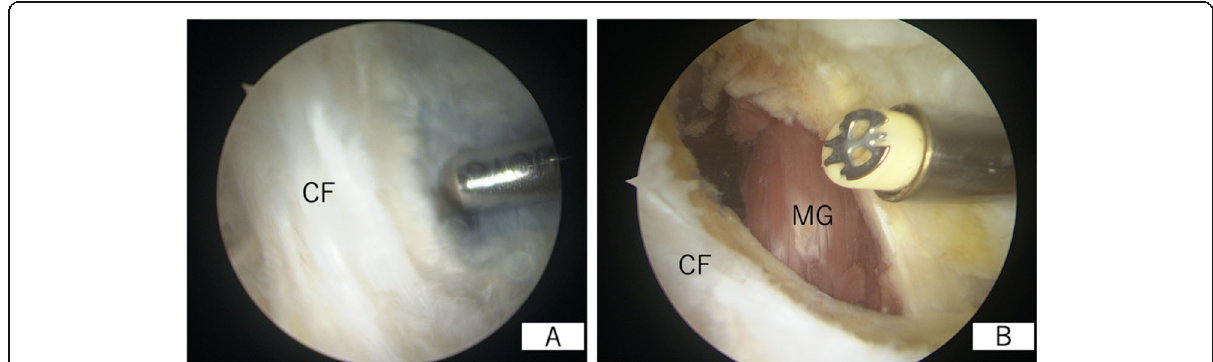
Fig. 4 Arthroscopic findings of the posteromedial compartment of the right knee via the anterolateral portal. a Indigo carmine is leaking out from the communication channel. b The arthroscopic enlargement is completed. CF: capsular fold; MG: medial gastrocnemius